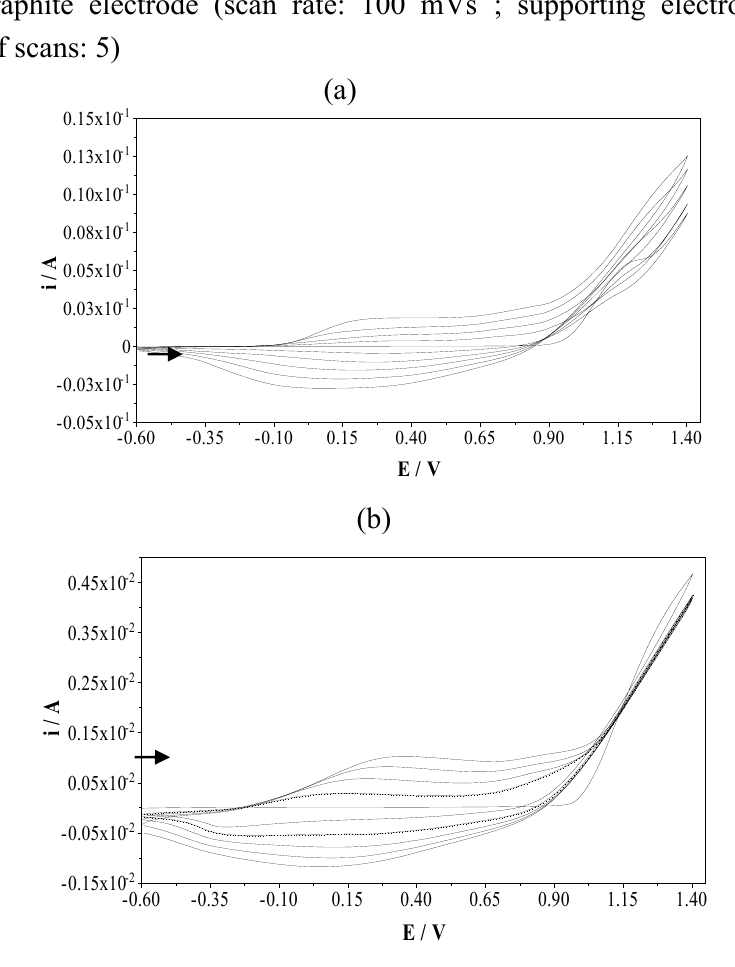
Figure 2. Cyclic voltammograms taken during the electropolymerization of pyrrole (0.1 M). (a) Multisweep cyclic voltammograms without and (b) with sulfamethoxazole (5 mM) onto a pencil graphite electrode (scan rate: 100 mVs -1 ; supporting electrolyte: 0.1